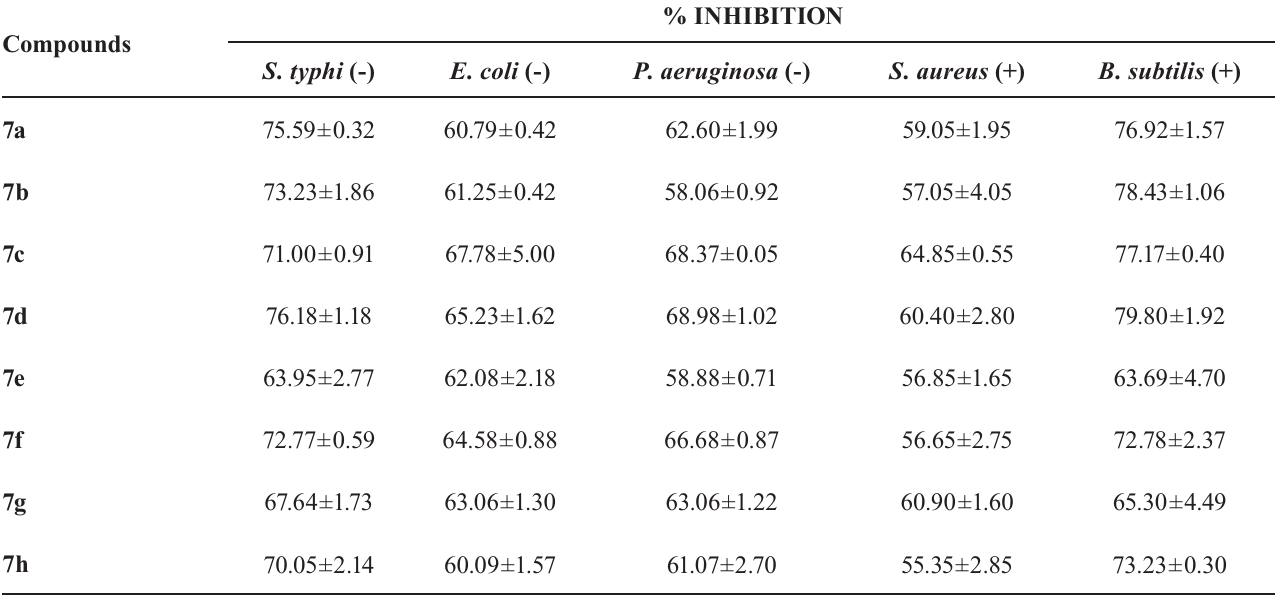
TABLE II - The % inhibition for antibacterial activity of synthesized compounds